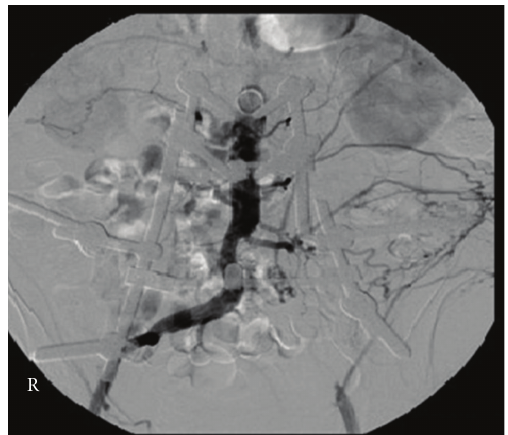
Figure 1: Right transfemoral angiogram at presentation showing occlusion to left common iliac artery extending into the left external iliac